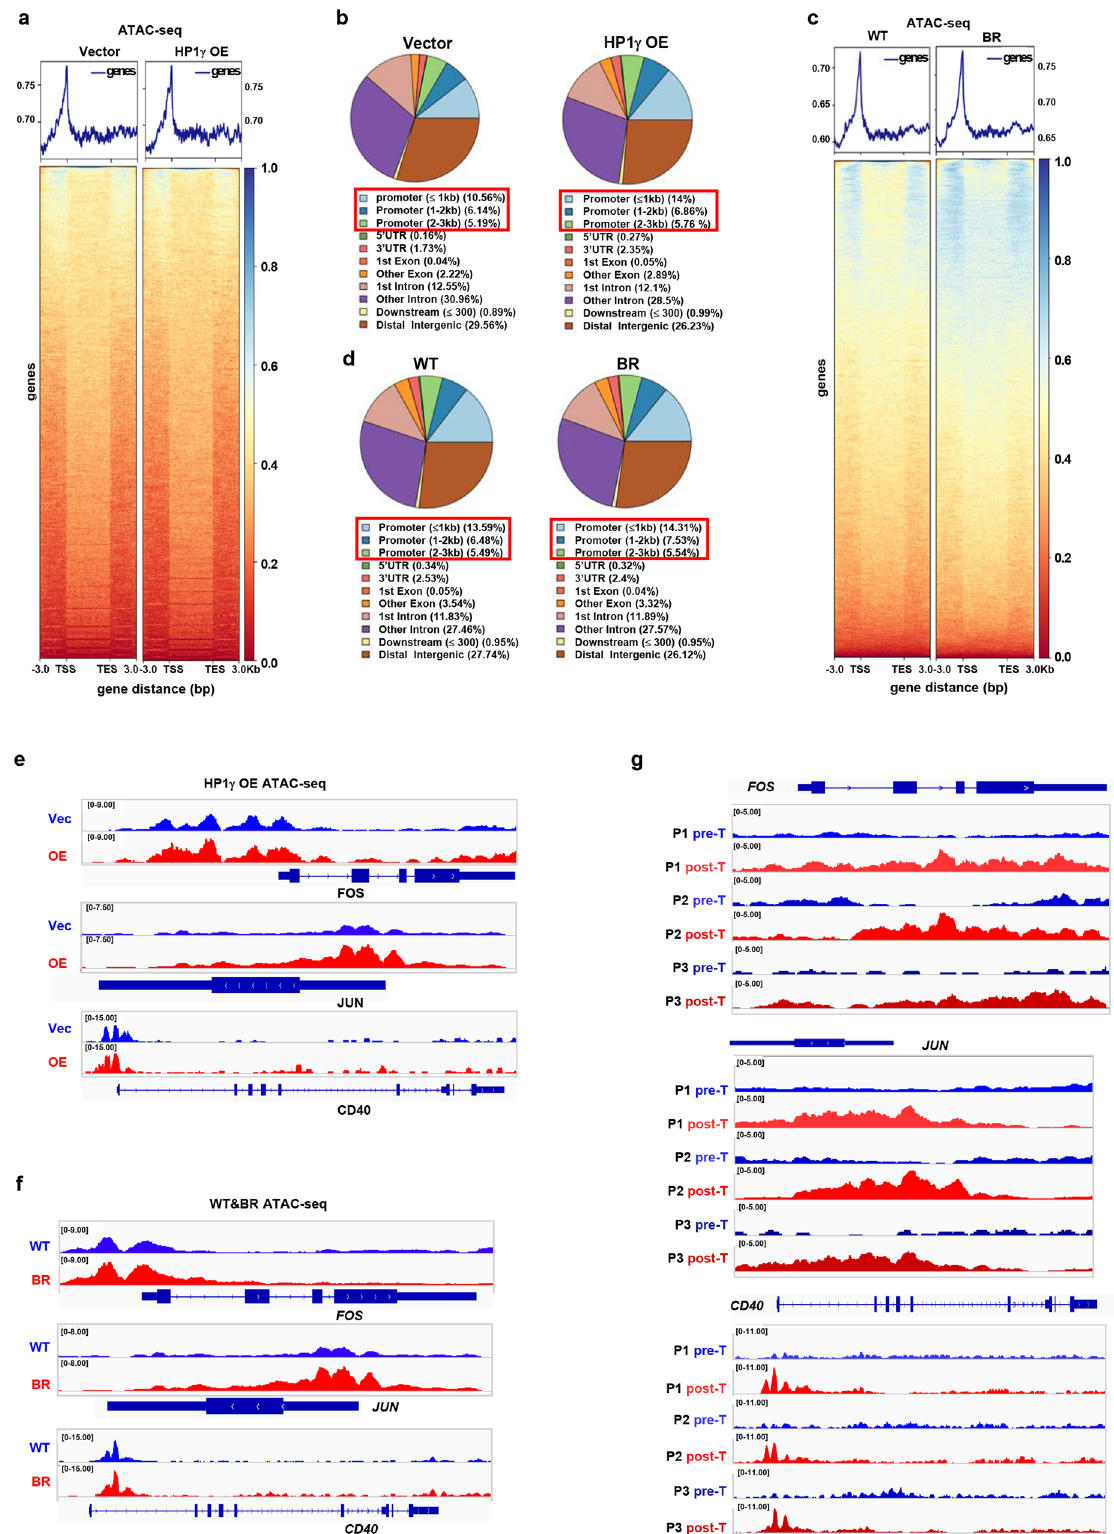
Fig. 7 | HP1 γ facilities chromatin accessibility of genes governing drug sensi- tivity.a ATAC-seqpro fi leofchromatinaccessibilityofgenesintheVectorandHP1 γ overexpressingLP-1cells( n = 3biologicallyindependentexperiments). b Genome- wide distribution of HP1 γ accessibility regions in the Vector and HP1 γ over- expressing LP-1 cells. c ATAC-seq pro fi le of chromatin accessibility of genes in the WTandBRLP-1cells( n = 3biologicallyindependentexperiments). d Genome-wide